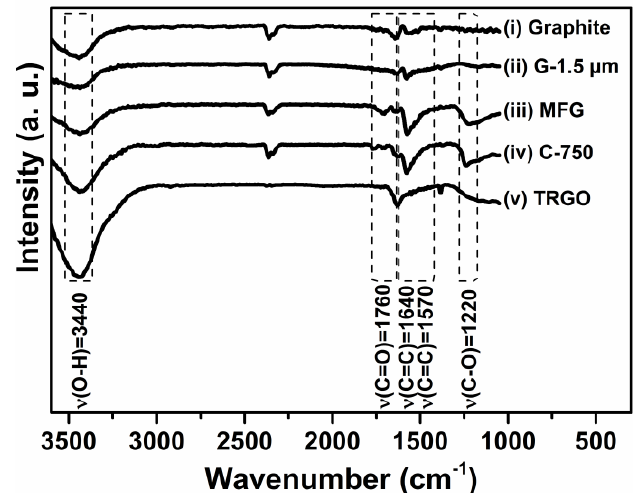
Figure 1. FTIR spectra of graphite (i), micronized graphite G-1.5 µm (ii), mechanochemically functionalized multilayer graphene MFG (iii), commercial functionalized graphene C-750 (iv), and thermally reduced graphite oxide TRGO (v), which was prepared by thermal reduction of graphite